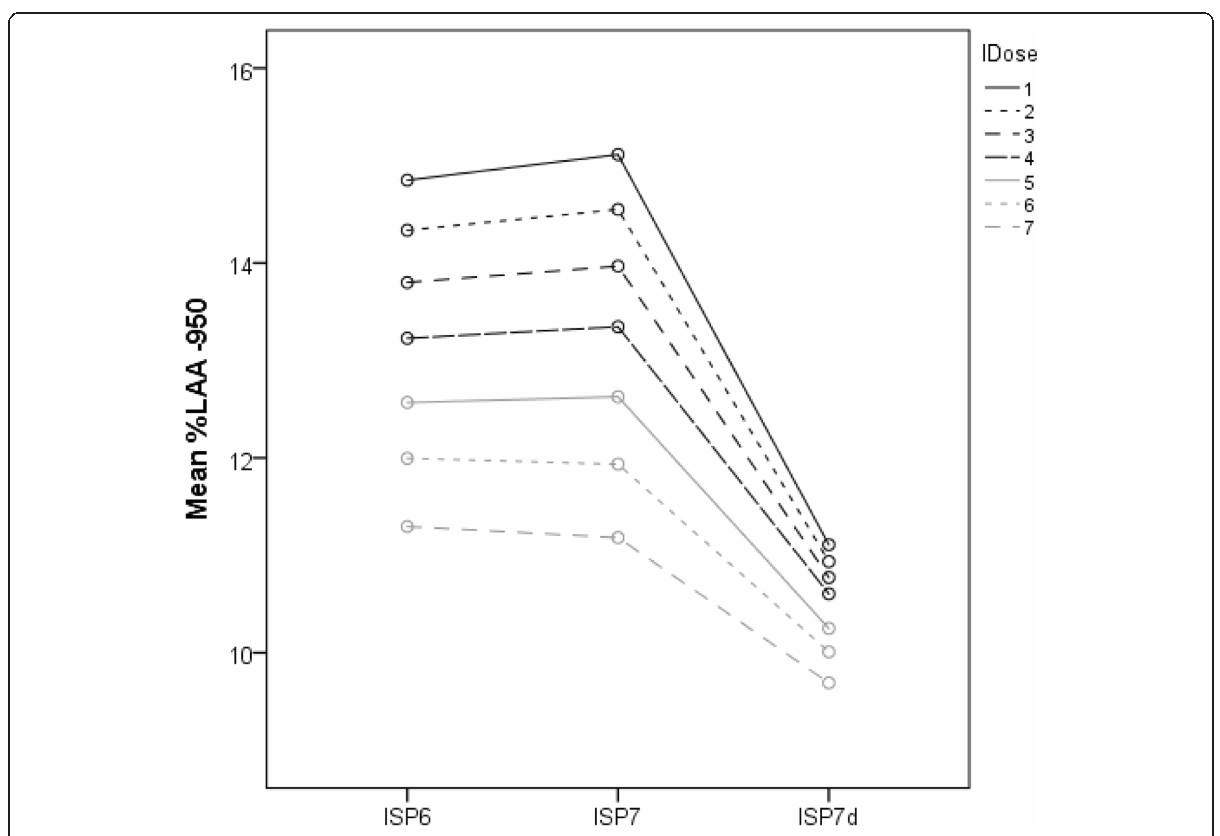
Fig. 3 Profile plot of %LAA-950 for the seven levels within ISP6, ISP7 with and without de-noising. % LAA - 950 percentage of lung voxels with attenuation < − 950 Hounsfield units, ISP IntelliSpace Portal, ISP7d ISP7 with